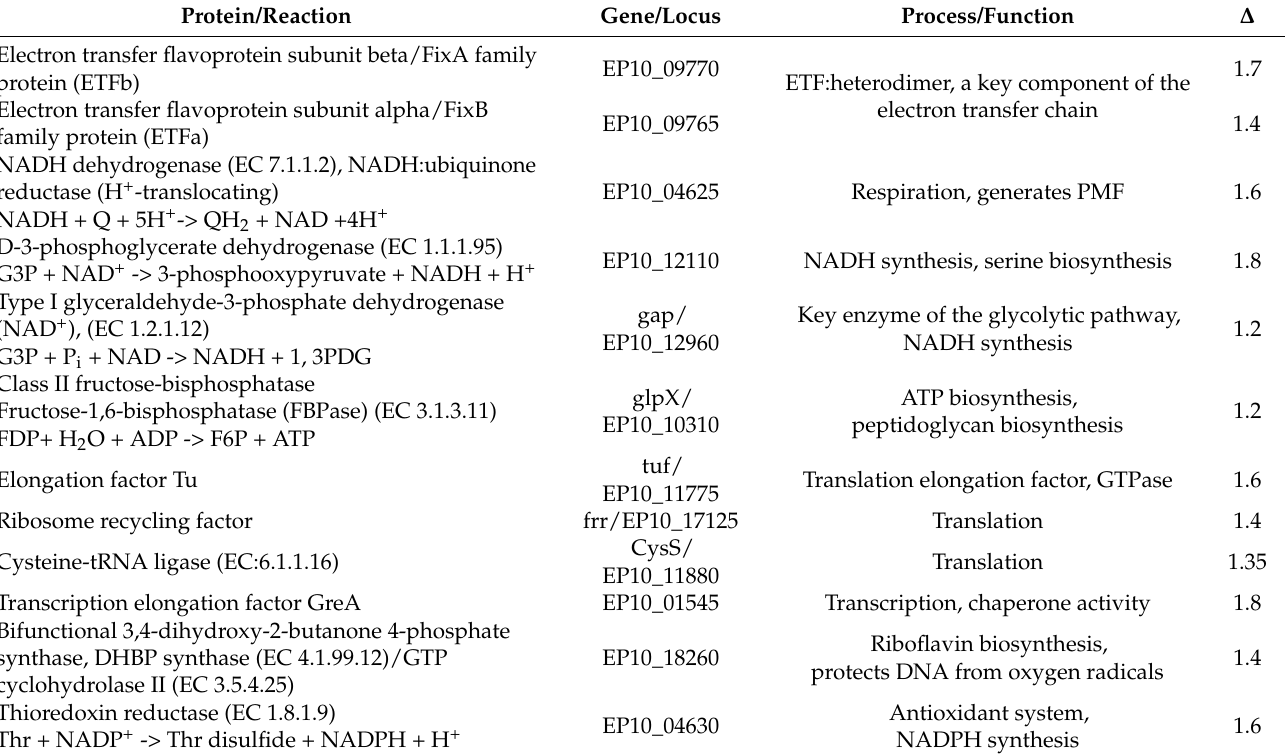
Table 1. The identified proteins found to be significantly downregulated in the proteomic profile of G. icigianus after 15 min of THz